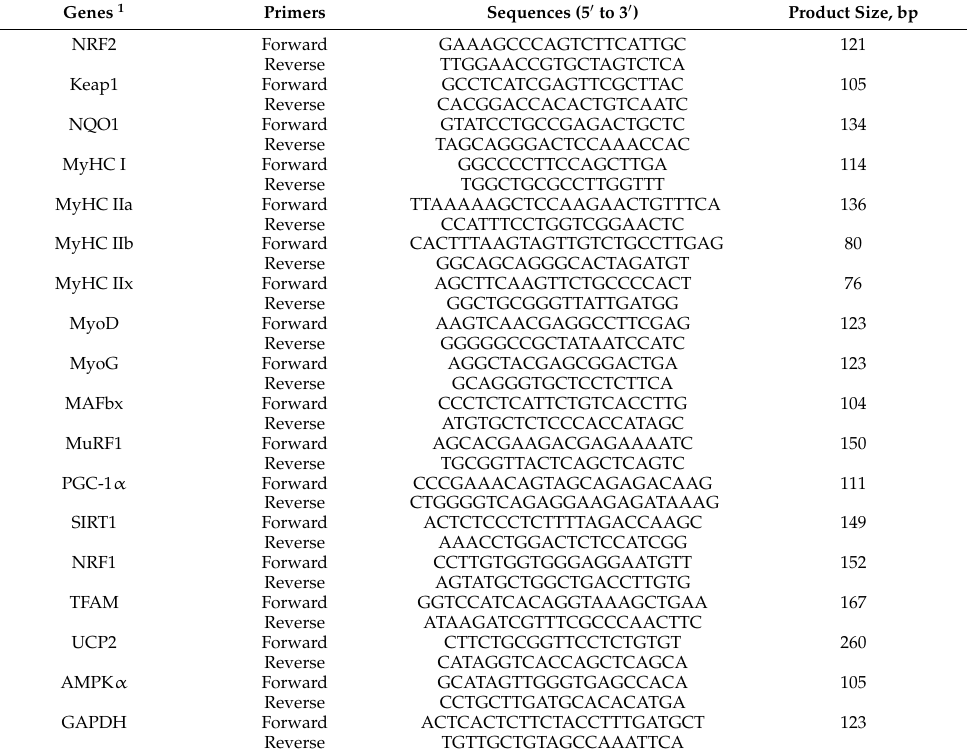
Table 2. Primers used for quantitative real-time